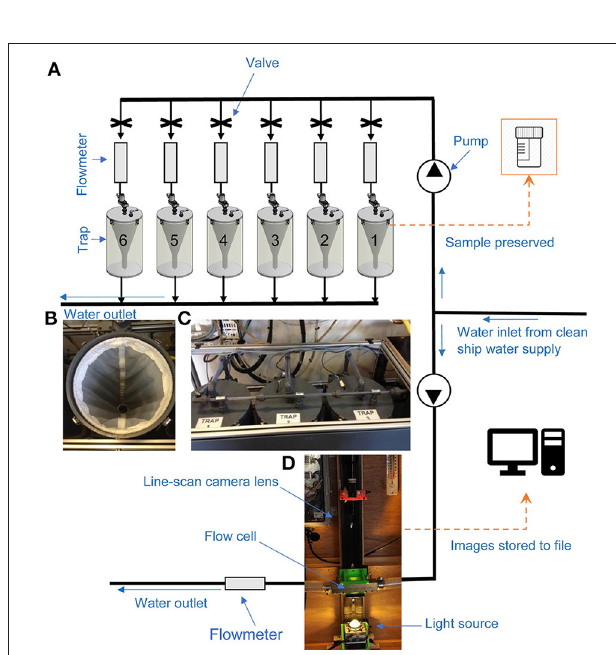
FIGURE 2 | Illustration showing the setup of the Continuous Automated Litter and Plankton Sampler (CALPS) and Plankton Image Analyser (PIA) on-board RV Cefas Endeavour during the PELTIC 2016 survey. (A) Schematic illustration of the CALPS system. (B) Photograph of the plankton net inside each trap on the trap system (C) from (A) . (D) Photograph of the PIA